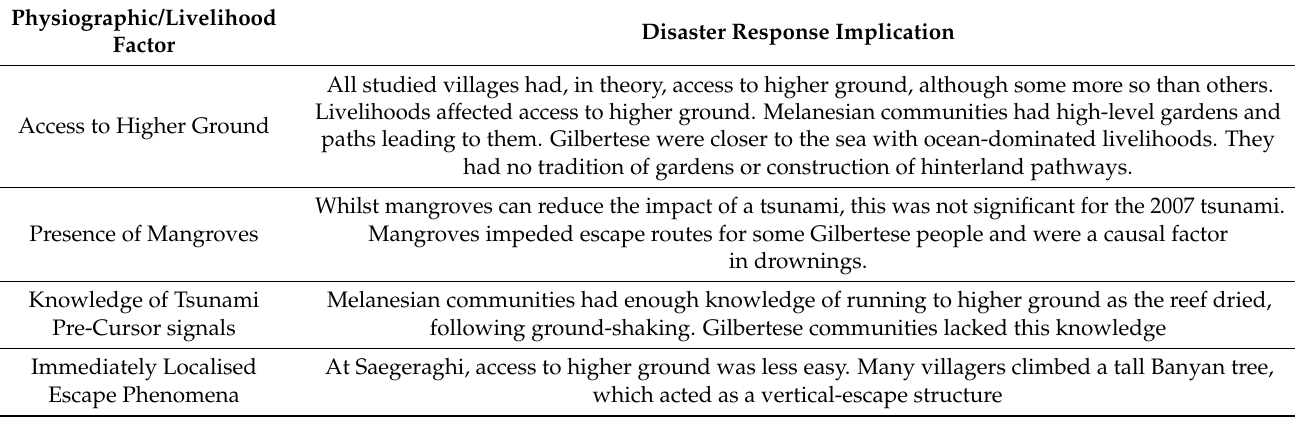
Table 5. Factors that impacted the immediate community response to the 2007